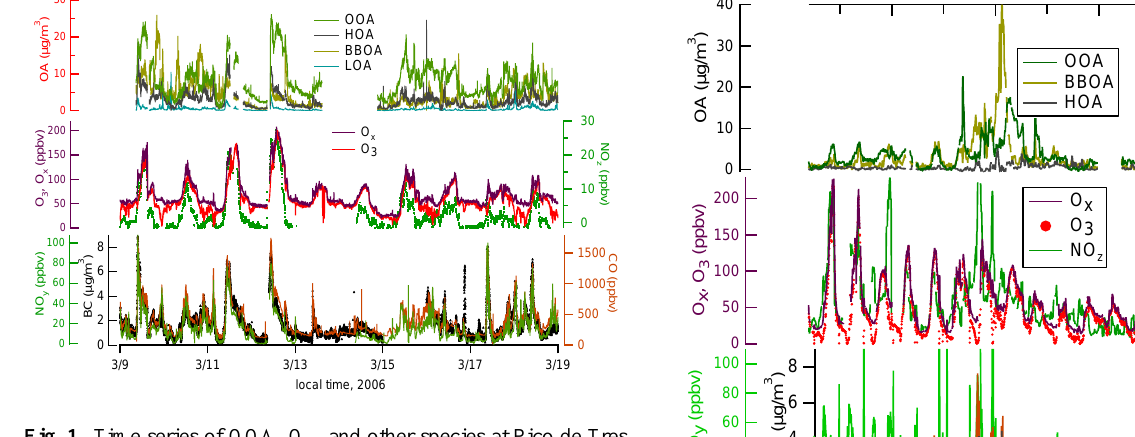
NCAR/NSF C-130 research flights on 10 March 2006 (RF3) and 29 March 2006 (RF12) consisted of segments both within the MCMA during the afternoon as well as segments sampling the aged MCMA outflow outside the MCMA (De- Carlo et al., 2010). RF3 was performed during a period in the campaign when biomass burning in and around Mexico City had a significant influence on the OA concentration measured aloft onboard the NCAR/NSF C-130. During RF12 the in- fluence of biomass burning was greatly reduced due to fre- quent rain that had suppressed fire activity near the end of the month (Aiken et al., 2010; Fast et al., 2007). Scatter plots between OOA and O x at PTP, La Porte, and the two C-130 research flights are shown in Fig. 3. Data from 11 March and 12 March 2006 are colored sep- arately in the top panel for distinction. Linear regres- sion slopes were determined using a bi-variate linear fit- ting routine (Neri et al., 1989). The uncertainty in the slopes is typically less than 10%. For the entire PTP